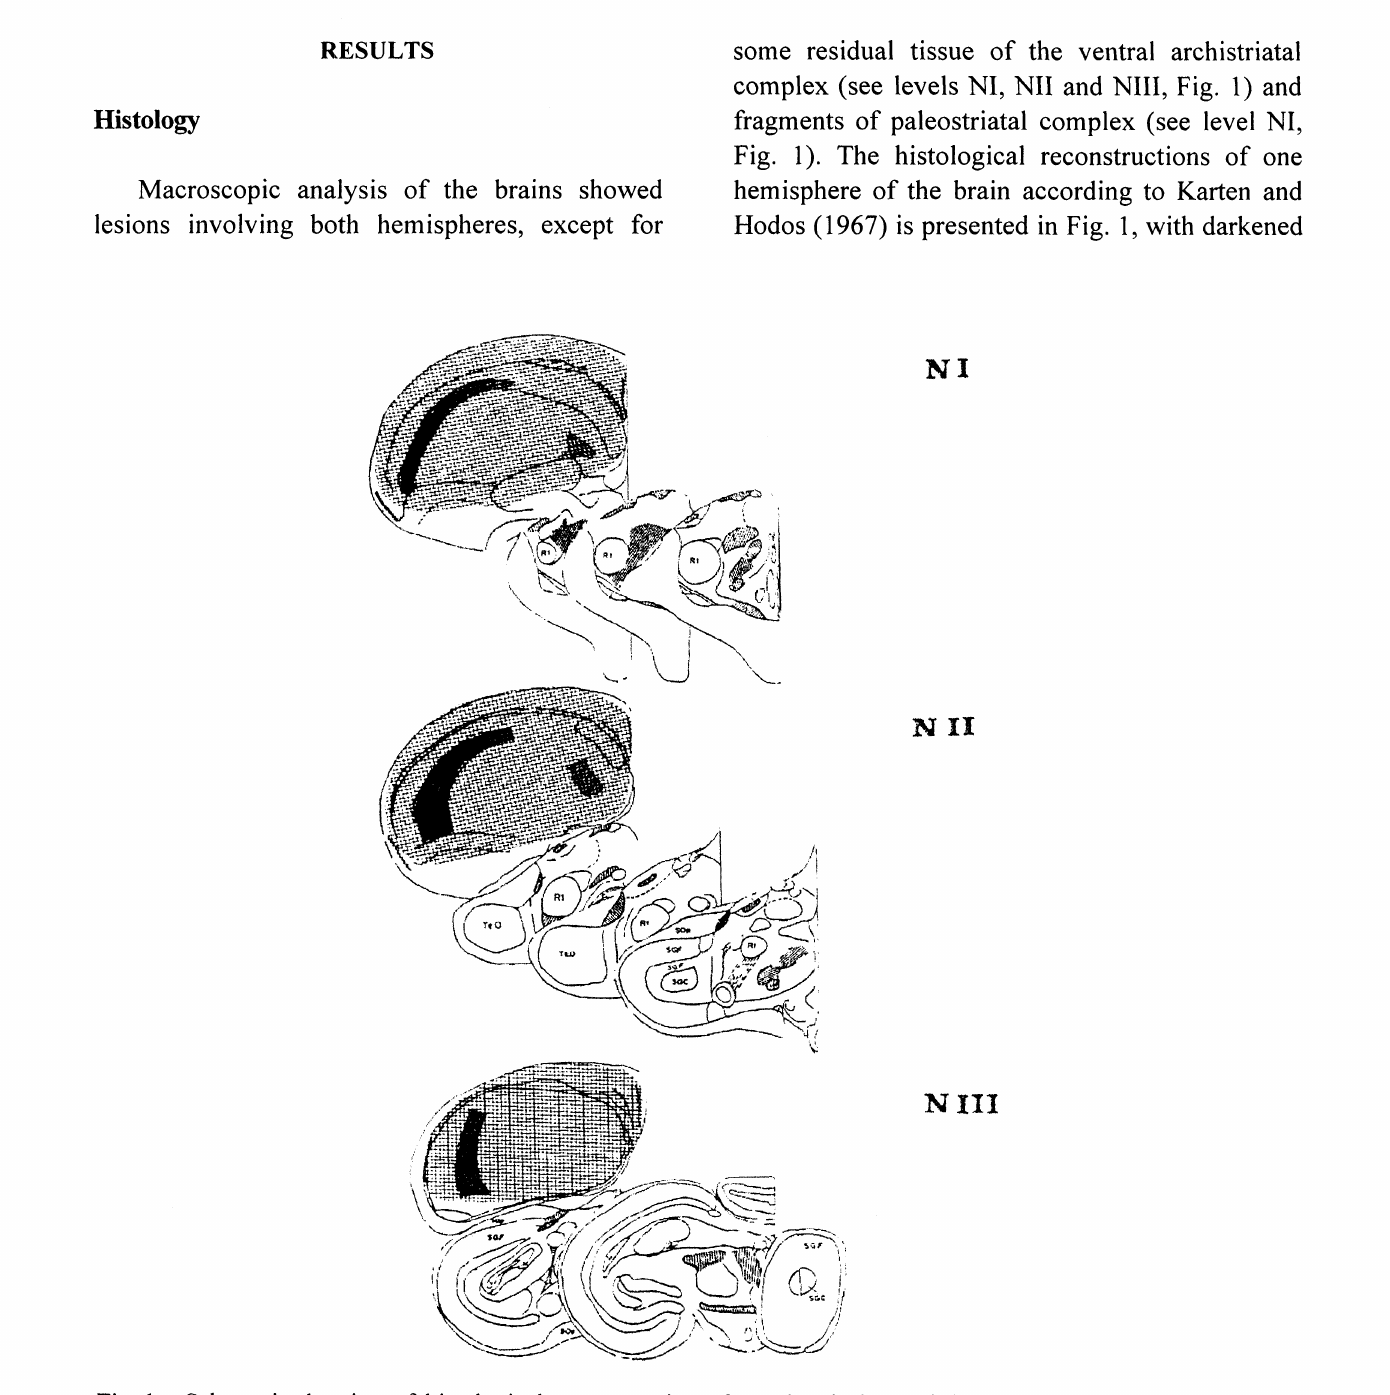
Fig. 1: Schematic drawing of histological reconstruction of one hemisphere of the brain of the pigeon (Karten & Hodos, 1967). Darkened gray areas indicate the extension of the lesion of the telencephalon, which is also valid for the omitted hemisphere. The indications NI, Nil and NIII refer to the levels defined for morphometric analysis.